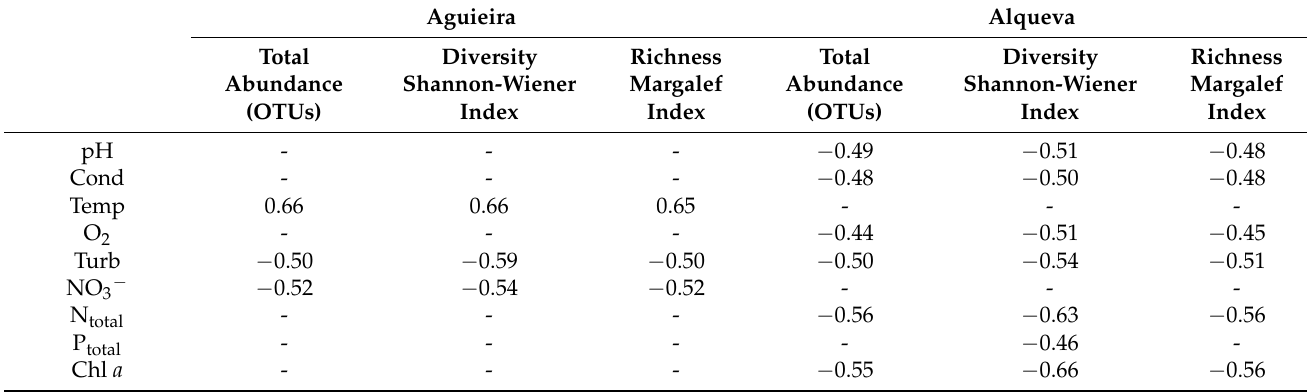
Table 3. Pearson’s correlation coefficient values among environmental parameters and bacterial communities in water from Aguieira and Alqueva reservoirs. Only statistically significant relations are presented ( p value < 0.05).